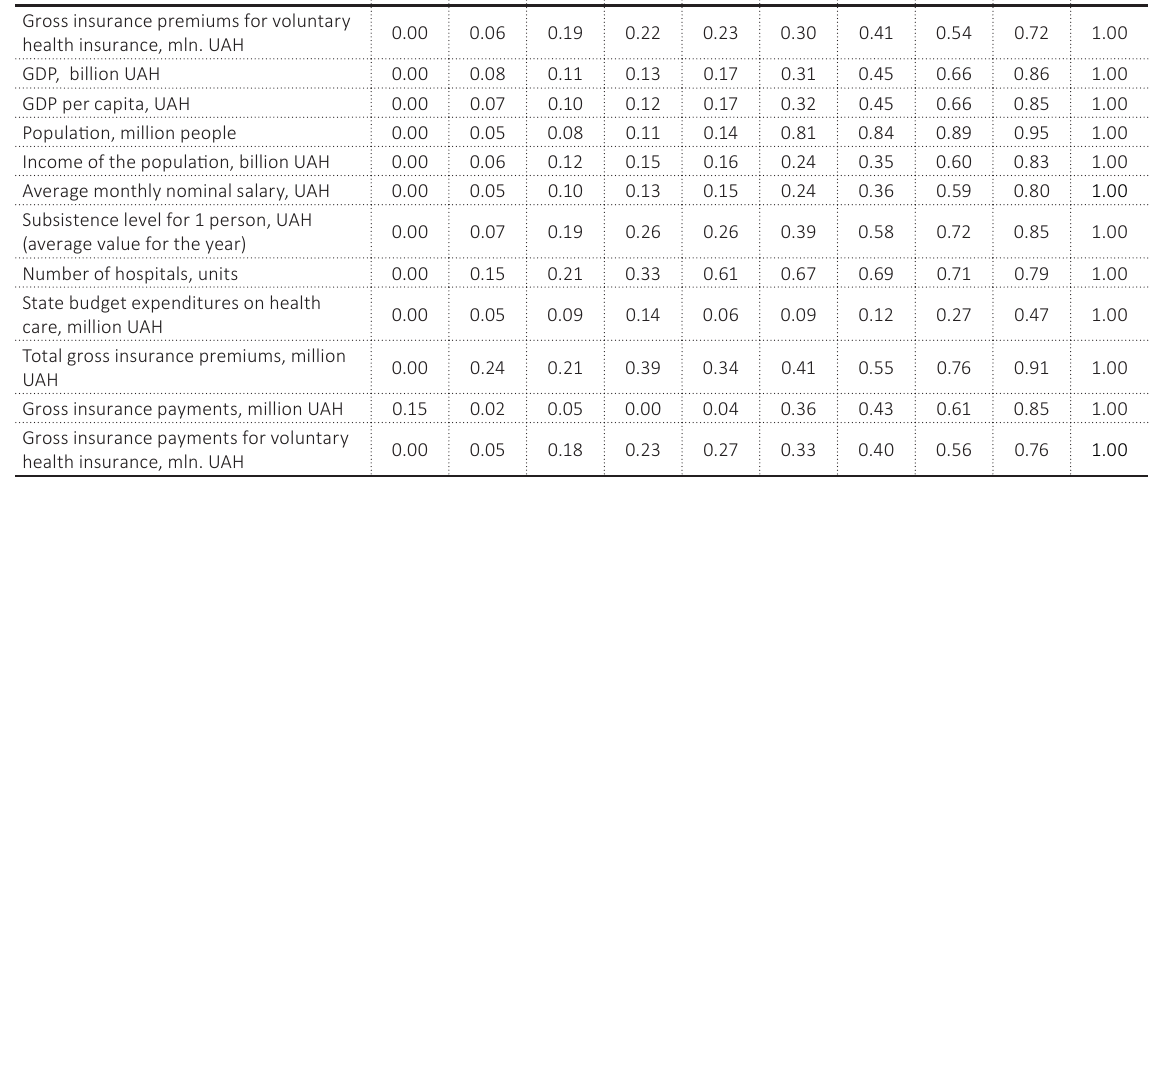
Table B2. The results of normalization of the study’s information base